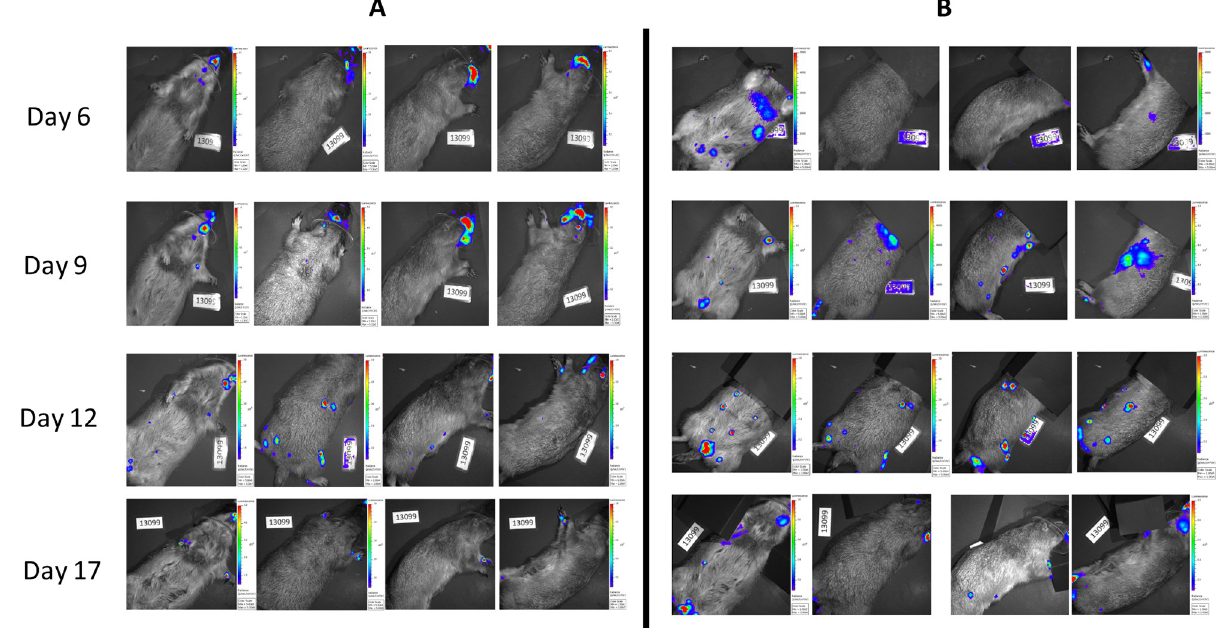
Fig 1. Time course of single Prairie dog infected with luc+ MPXV. Representative single Prairie dog infected with luc+ MPXV and imaged on indicated days to determine areas of luciferase production representing areas of replicating MPXV. Images are black and white photograph of a representative prairie dog taken at each time point overlaid with a false color representation of photon emission intensity as indicated by the scale on the right in ps -1 cm -2 sr -1 . Images where animals were imaged without any coverage of highly luminescent areas (A). Images where areas of high luminescence were covered by black construction paper and animals were re-imaged to visualize other areas that may require longer exposure rates (B).